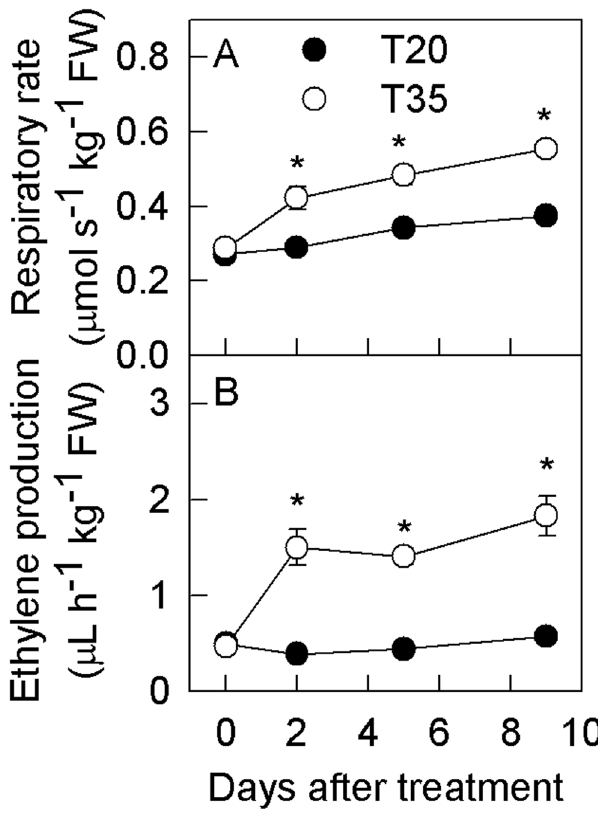
Figure 3. Dark respiration ( A ) and ethylene production ( B ) of plum fruits treated at 20 °C and 35 °C for different time in the dark. Each data point represents mean ± SE (n = 5). The asterisk indicates a significant difference between two temperature treatments at P < 0.05, t